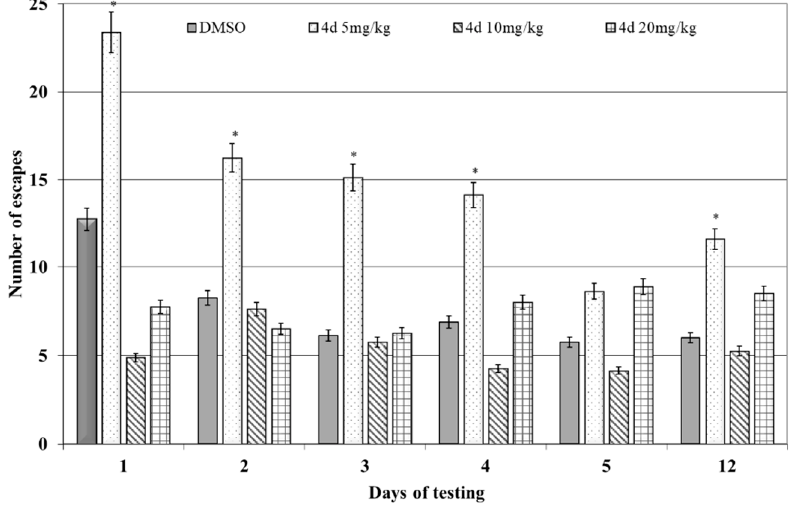
Figure 5. Effects of 4d on learning and memory processes in rats (shuttle-box active avoidance test,